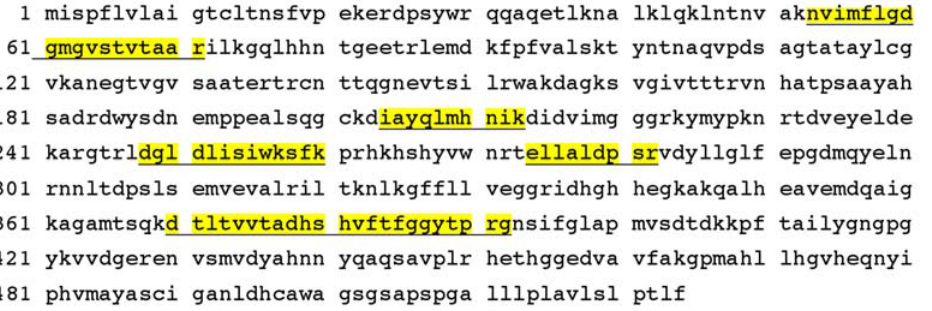
Figure 4. The 80 kDa PrP C partner is identified as TNAP by mass spectrometry. The position of the 5 peptides identified by mass spectrometry (LC/MS/MS) with the best scores, is highlighted along the mouse TNAP protein